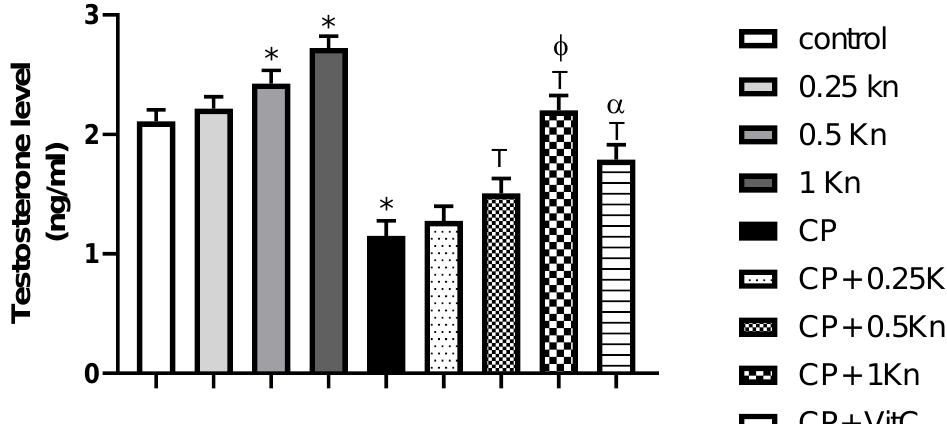
Figure 3. Effect of different doses of kinetin and vitamin C on serum testosterone level in cisplatin- treated rats. Data are represented as mean ± SEM, *, T, ф and α are significant differences from control, 0.25 Kn, CIS, CIS+ 0.25 Kn and CIS+ 1 Kn groups, respectively, at p < 0.05 where n = 5 – 6. Kn, kinetin; CIS, cisplatin; VitC, vitamin C.